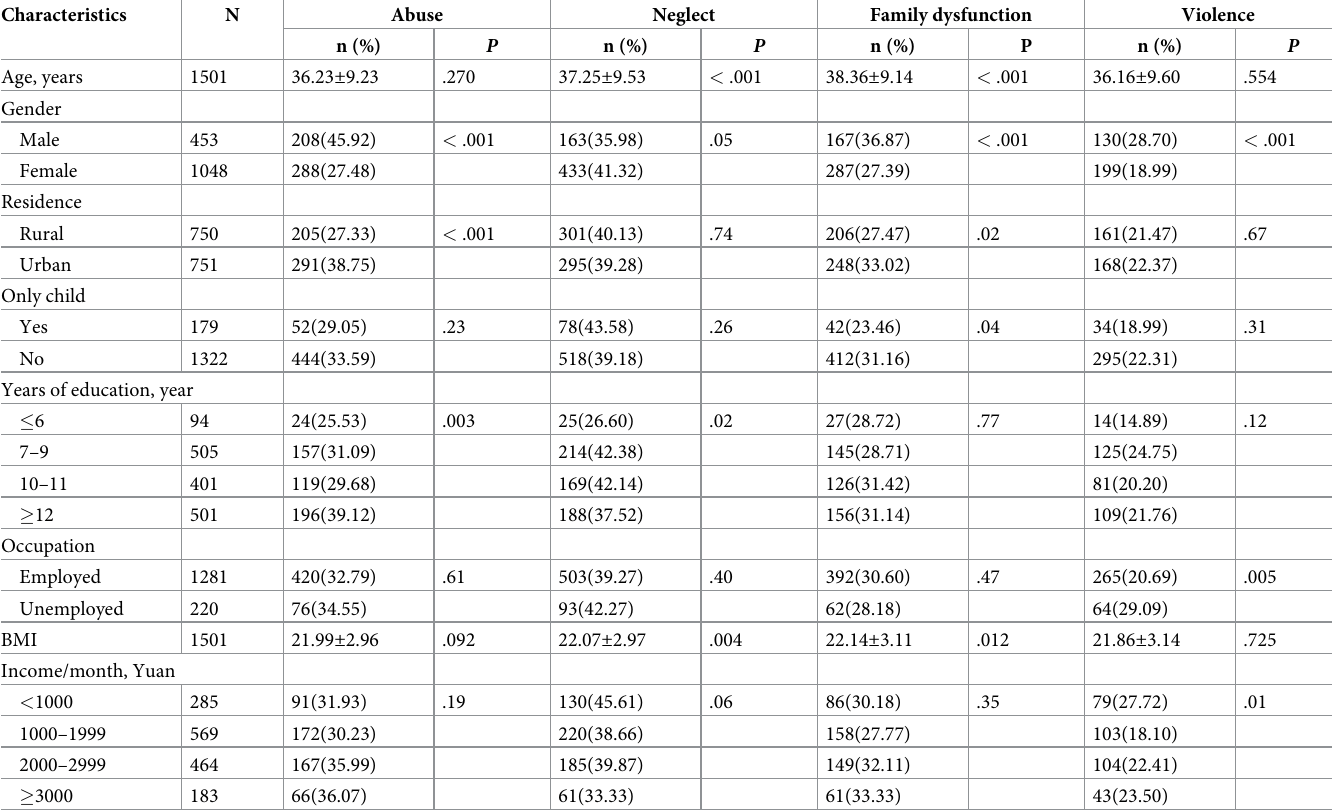
Table 1. Demographics of participants aged 18–59 years by ACE categories. Characteristics